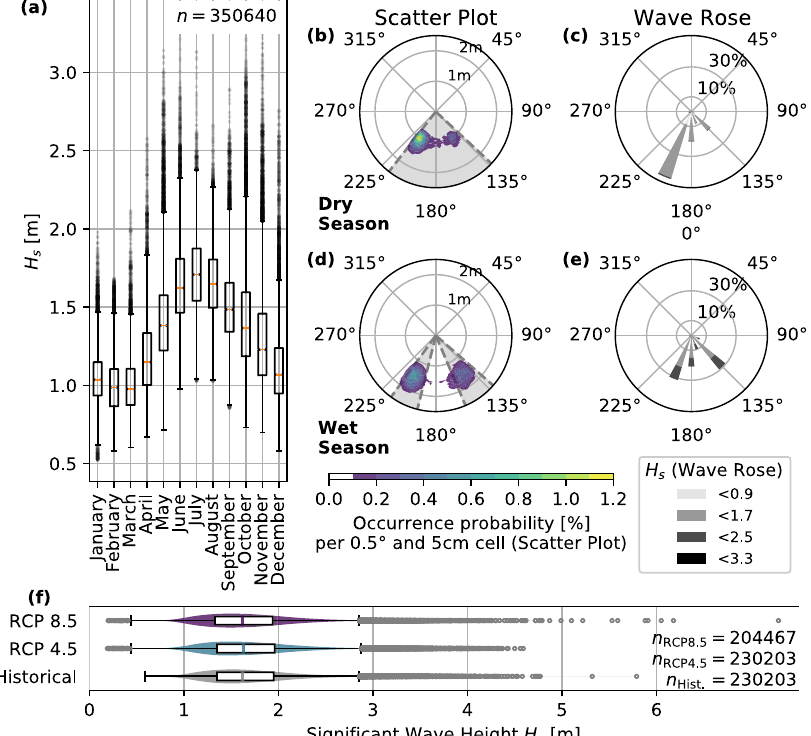
Fig. 5 Wave statistics for Fuvahmulah. a Annual signi fi cant wave height distribution for hindcast data between 1980 to 2019 (sample size n = 350,640). b shows the discrete marginal distribution between peak wave direction θ p and signi fi cant wave height H s for the dry season, while d contains results for the wet season. Here, the colorbar shows the occurrence probability of each 0.5 ∘ wave direction and 0.05 m wave height cell. The gray areas visualize the signi fi cant peak direction range θ p , r for each subset, containing the directions which, when combined, have the highest 33% occurrence probability. c and e show wave roses for the dry and wet season. f are signi fi cant wave heights for 2010 – 2019 (here labeled as “ Historical ” ; sample size n = 204,467; unde fi ned “ NaN ” , or “ Not a Number ” , values remain unconsidered) and Representative Concentration Pathway (RCP) 4.5 and 8.5 (sample size n = 230,203; unde fi ned “ NaN ” values remain unconsidered). Boxplots in a and f are done with the corresponding boxplot-function in Python ’ s module matplotlib. Here, the orange line of the boxplot is the median, the box limits are the upper and lower quartiles while whiskers mark the range of the non- outlier data and extend the box limits by 1.5 ⋅ IQR.